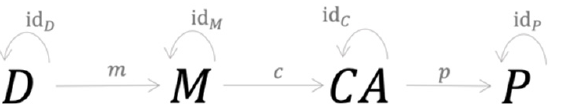
Figure 1. Categorical construct of credit risk modeling based on optimal capital allocation. At first sight, this category appears similar to the one representing current approaches to modeling credit risk, 3 where object D represents a data structure that forms the basis of which specific data are collected, processed, analyzed and used in both the testing and training process, and object M represents model choice with the morphism m between D and M defined by a computational process that optimally maps the specific training dataset to a unique model. Nevertheless, substantial differences are apparent. First, the object C , representing the confusion matrix, is replaced by a new object CA , representing the predicted PDs and corresponding credit allocation amount. The morphism c now represents the Kelly betting strategy, and p represents the process of turning instances of CA into various measurements of performance, as proposed above, which constitute the elements of the object P . Based on this category framework, a computational implementation is developed, which is the subject of the next